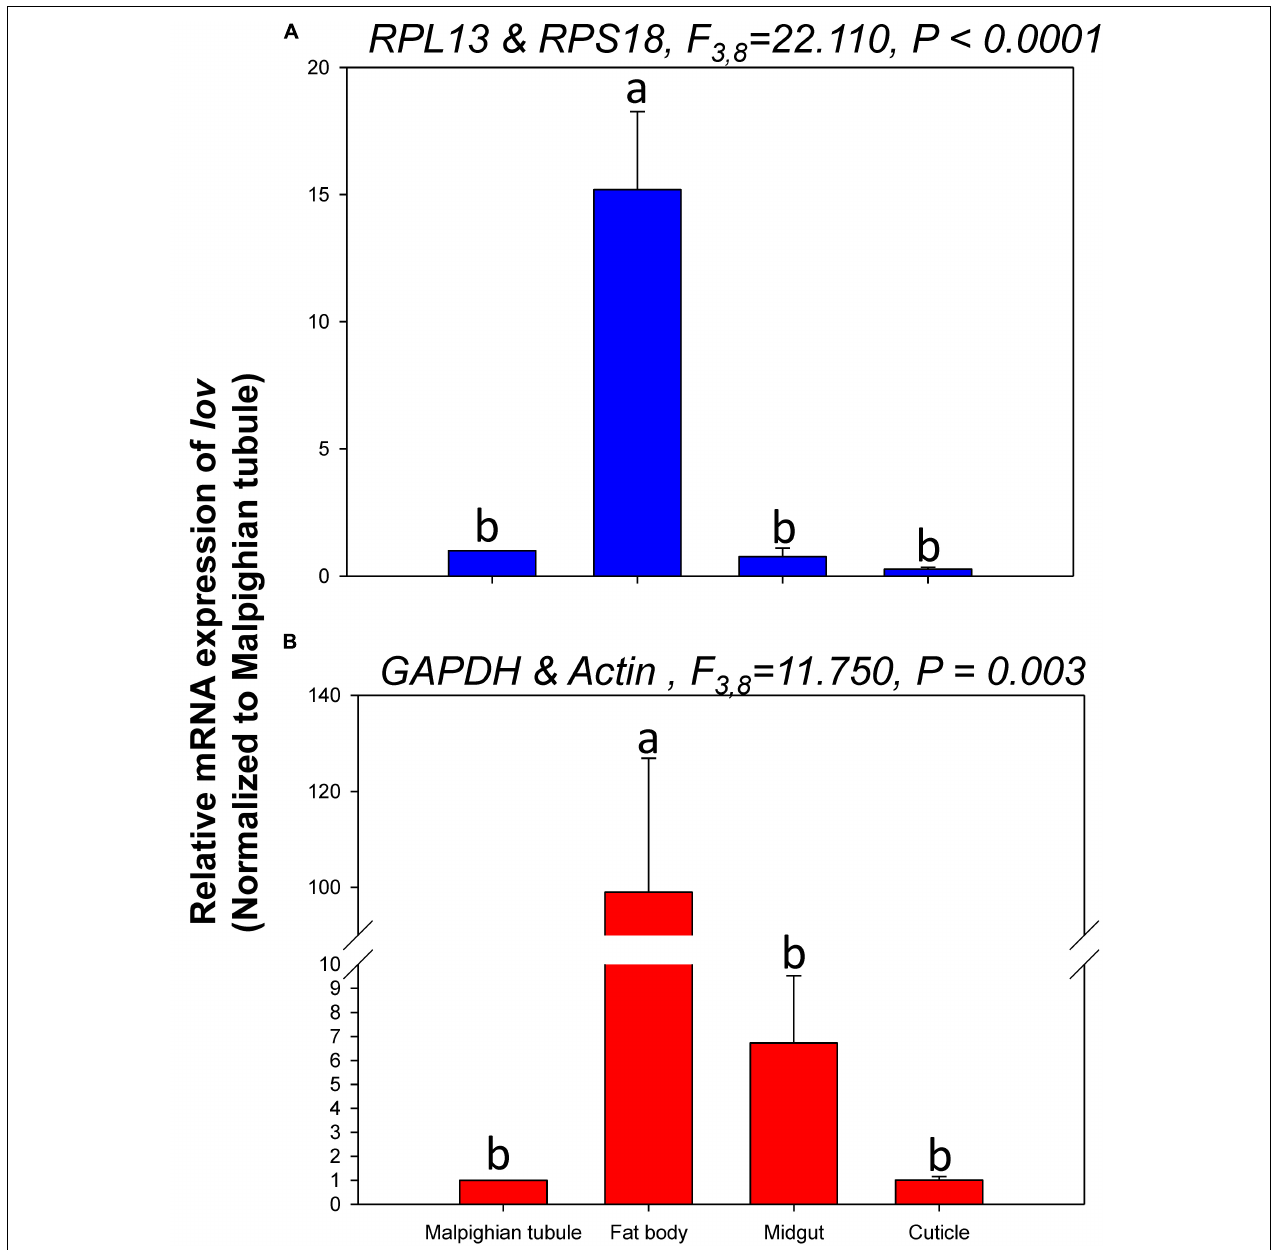
FIGURE 5 | Relative gene expression of lov in different tissues of H. vigintioctomaculata . The relative abundance of lov in the Malpighian tubule, fat body, midgut, and cuticle were normalized to the best stable ( A , RPL13 and RPS18 ) and least stable ( B , GAPDH and Actin ) reference genes, respectively. The values are means + SE. Different letters indicate significant differences in gene expression among different tissues of H. vigintioctomaculata ( P <